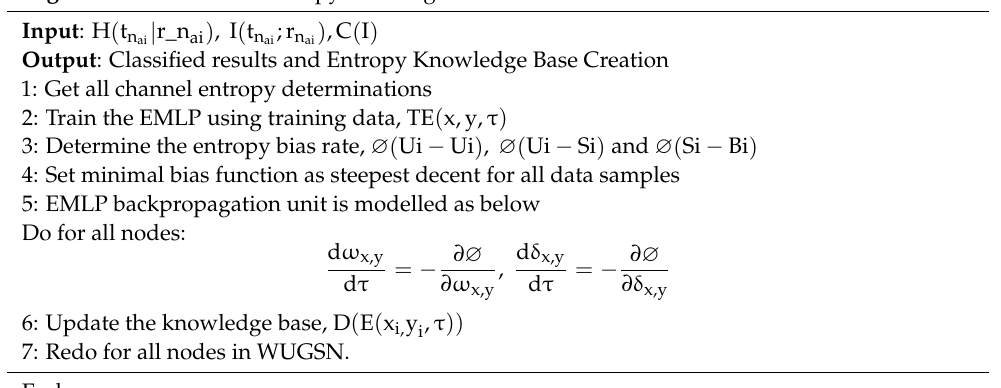
Algorithm 2: EMLP for Entropy Learning and